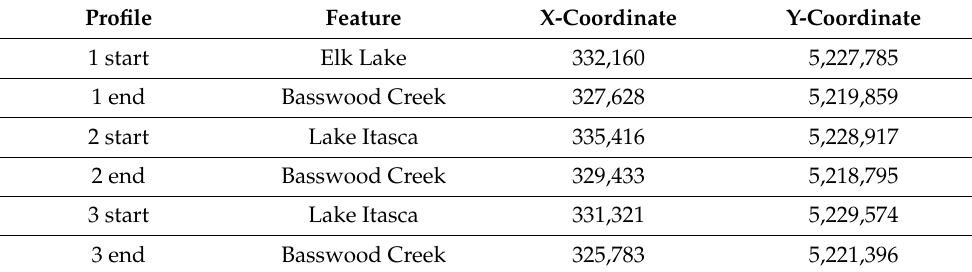
Table A2. Projected coordinates of profiles (UTM Zone 15 NAD83).